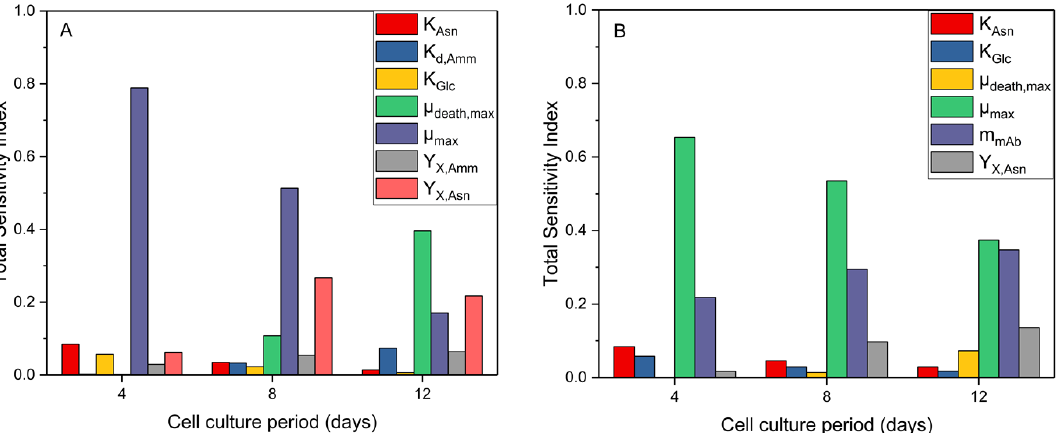
Figure 4. TSI for different parameters examining their effect on ( A ) viable cell density and ( B ) antibody concentration. The parameters’ deviation was set at 10% and the used sampling method was Scrambled Sobol’.